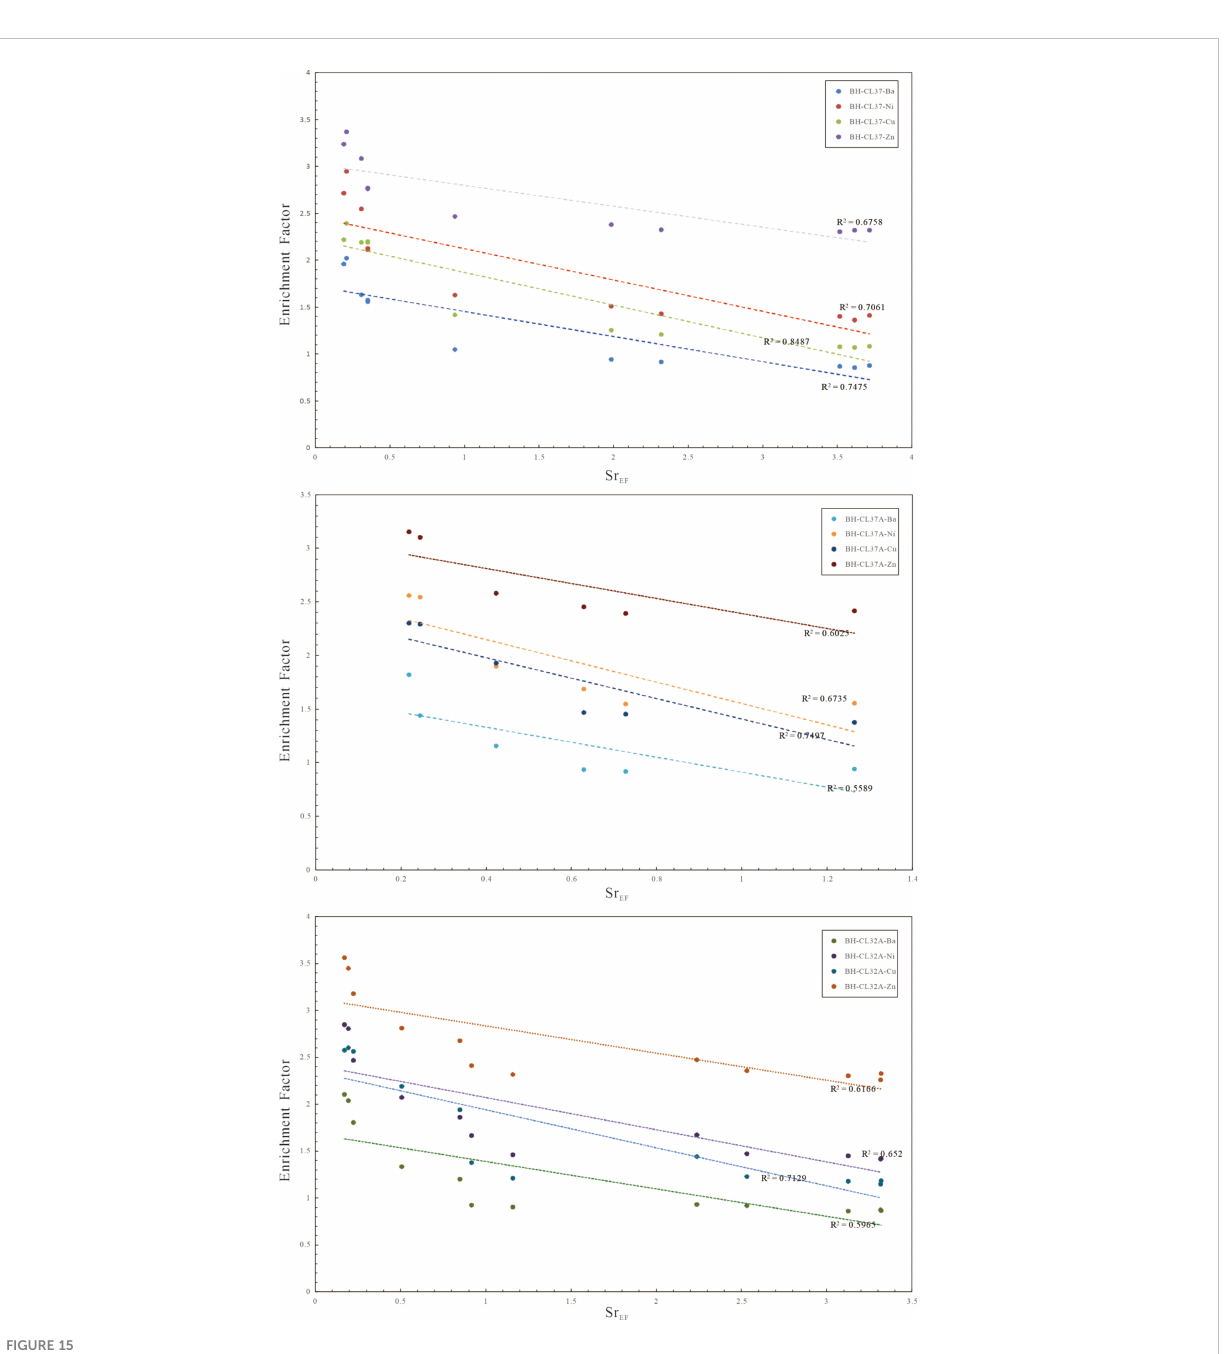
FIGURE 15 Correlations between Sr EF and enrichment factors of trace elements (Ba, Ni, Cu,